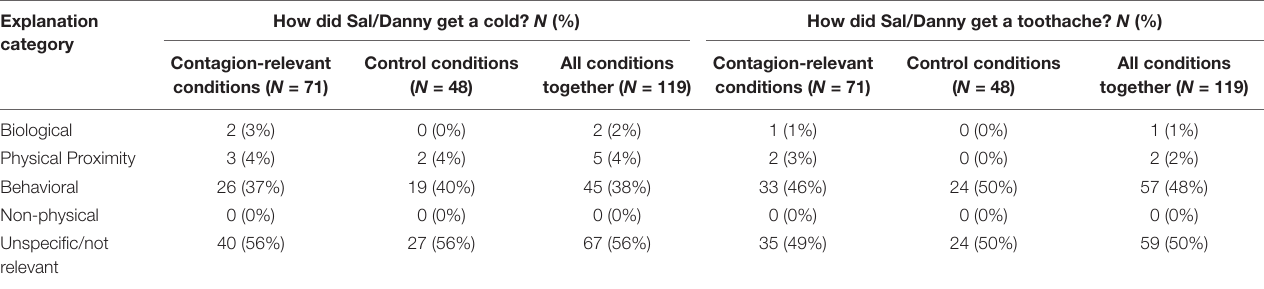
TABLE 2 | Coding categories of children’s provided open-ended explanations at baseline for the questions “How did Sal/Danny get a cold/toothache?” across all conditions. Explanation category